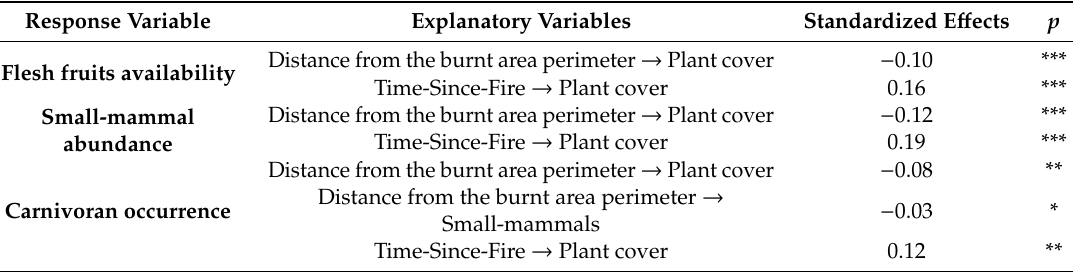
Table 3. Structural equation models (SEM) indirect standardized e ff